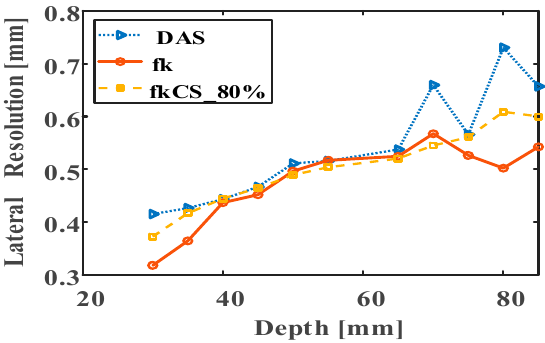
Figure 6. Effect of depth on the lateral resolution. Table 1. Contrast of DAS, Stolt’s f-k and proposed framework.